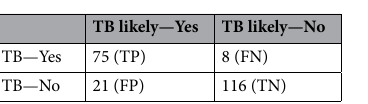
Table 4. Confusion matrix for the validation phase.